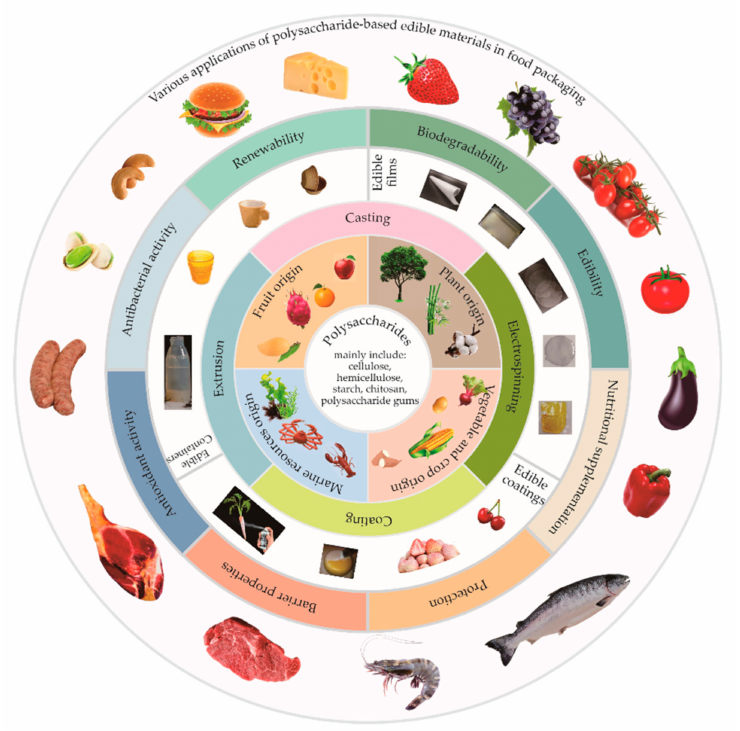
Figure 1. The major sources, types, processing methods, product forms, and food preservation applications of polysaccharide-based edible